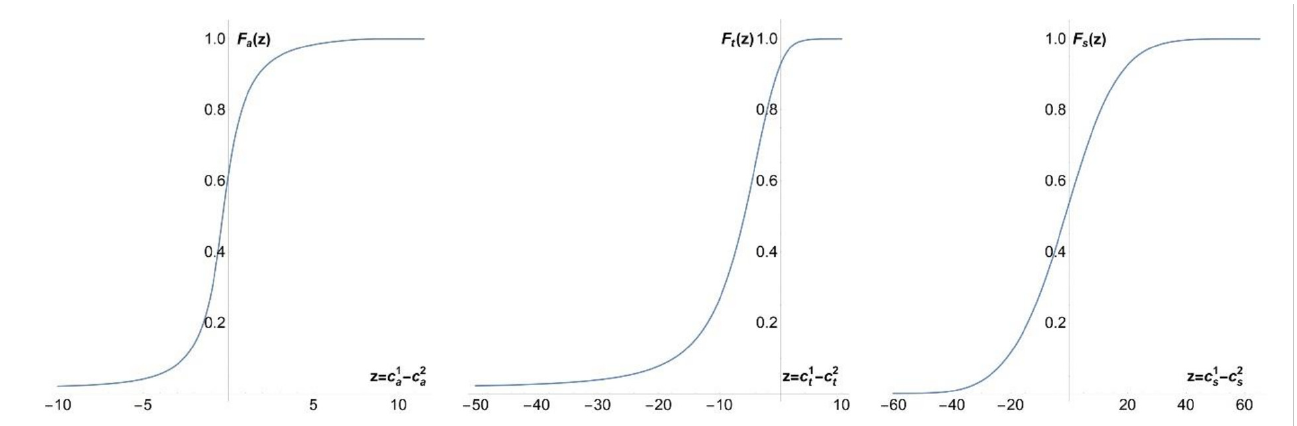
Figure 20. CDF of the NiTi-1 and NiTi-2 alloys’ corrosion rate difference under air, tide, and sea